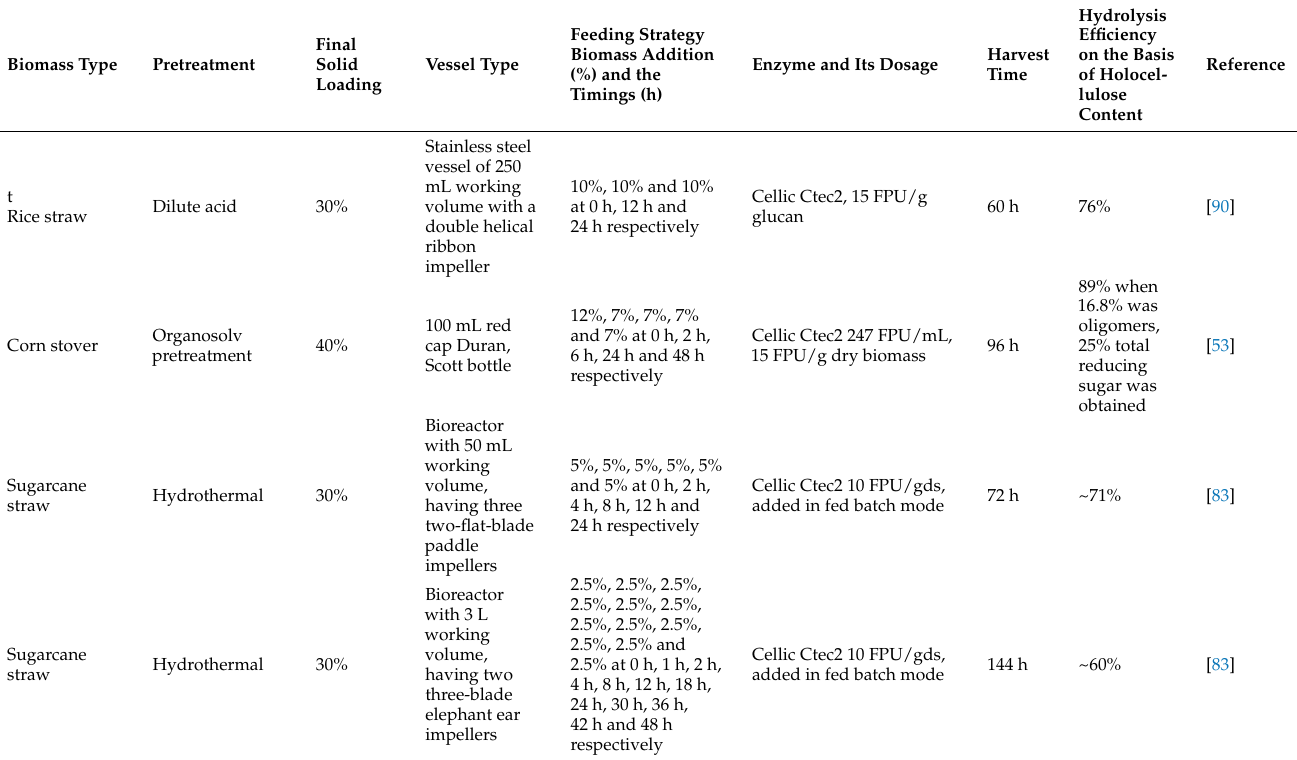
Table 4. High solid loading of biomass adopting fed-batch mode for increased sugar